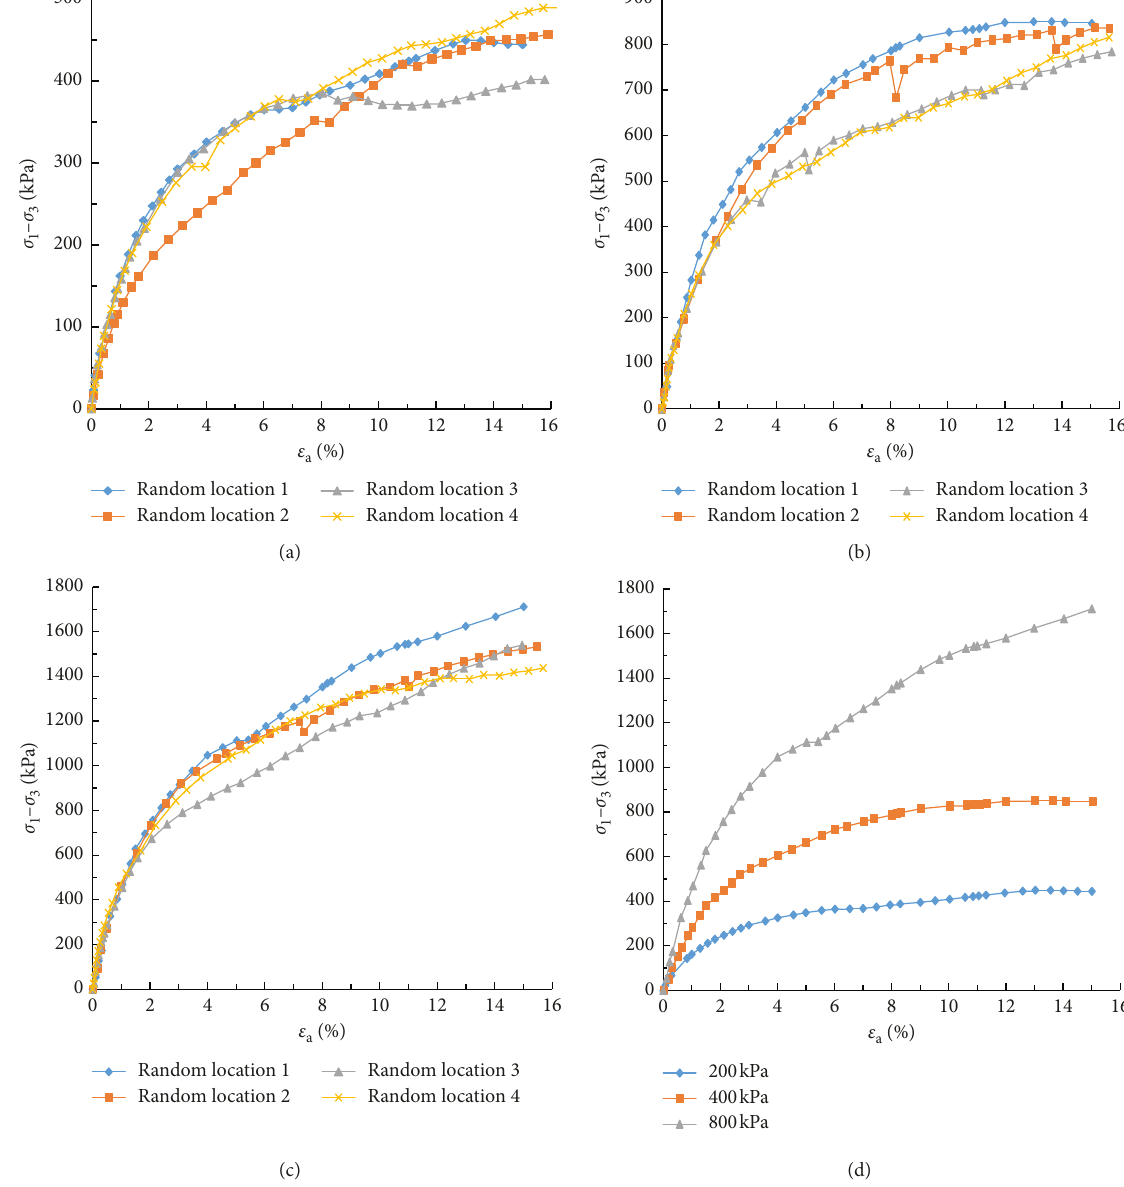
Figure 9: Curves of ( σ 1 − σ 3 ) ∼ ε under different rock contents or random location 1: (a) 200kPa confining pressure; (b) 400 kPa confining pressure; (c) 800 kPa confining pressure; (d) random location 1. Table 8: Strength index of different random distributions. Random